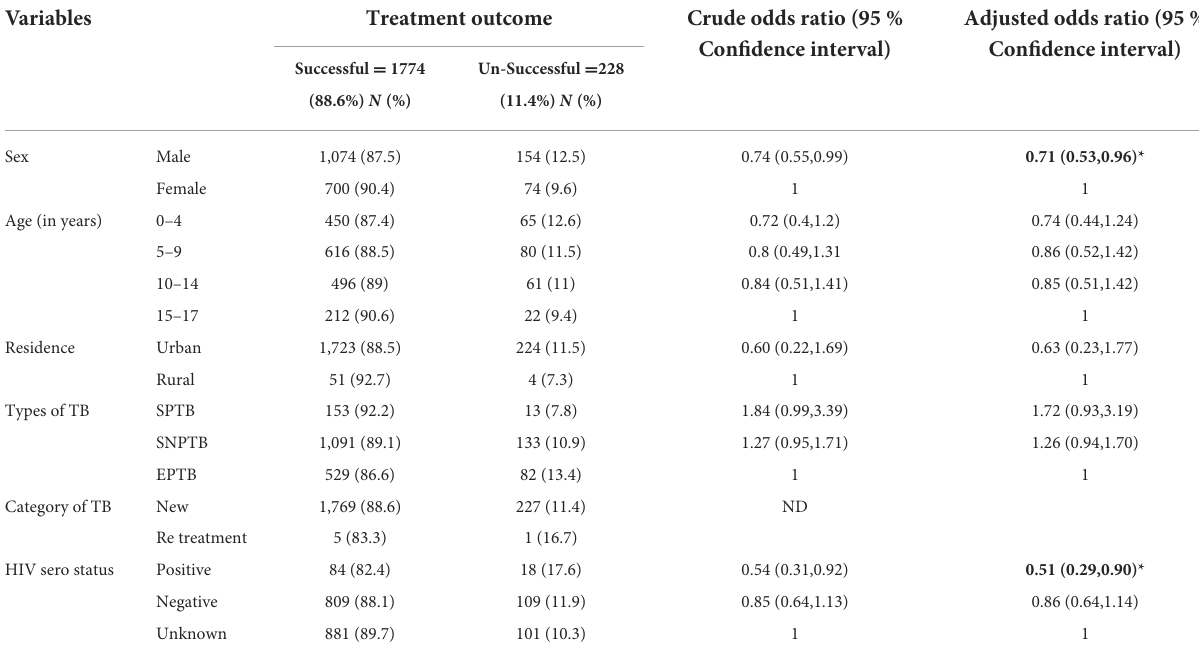
TABLE 5 Factors associated with treatment outcome of tuberculosis among children with TB attending Treatment in selected health institutions in eastern Ethiopia, 2017 ( n = 2,002). Variables Treatment outcome Crude odds ratio (95 % Adjusted odds ratio (95 % Confidence interval) Confidence interval) Successful = 1774 Un-Successful = 228 (88.6%) N (%) (11.4%) N